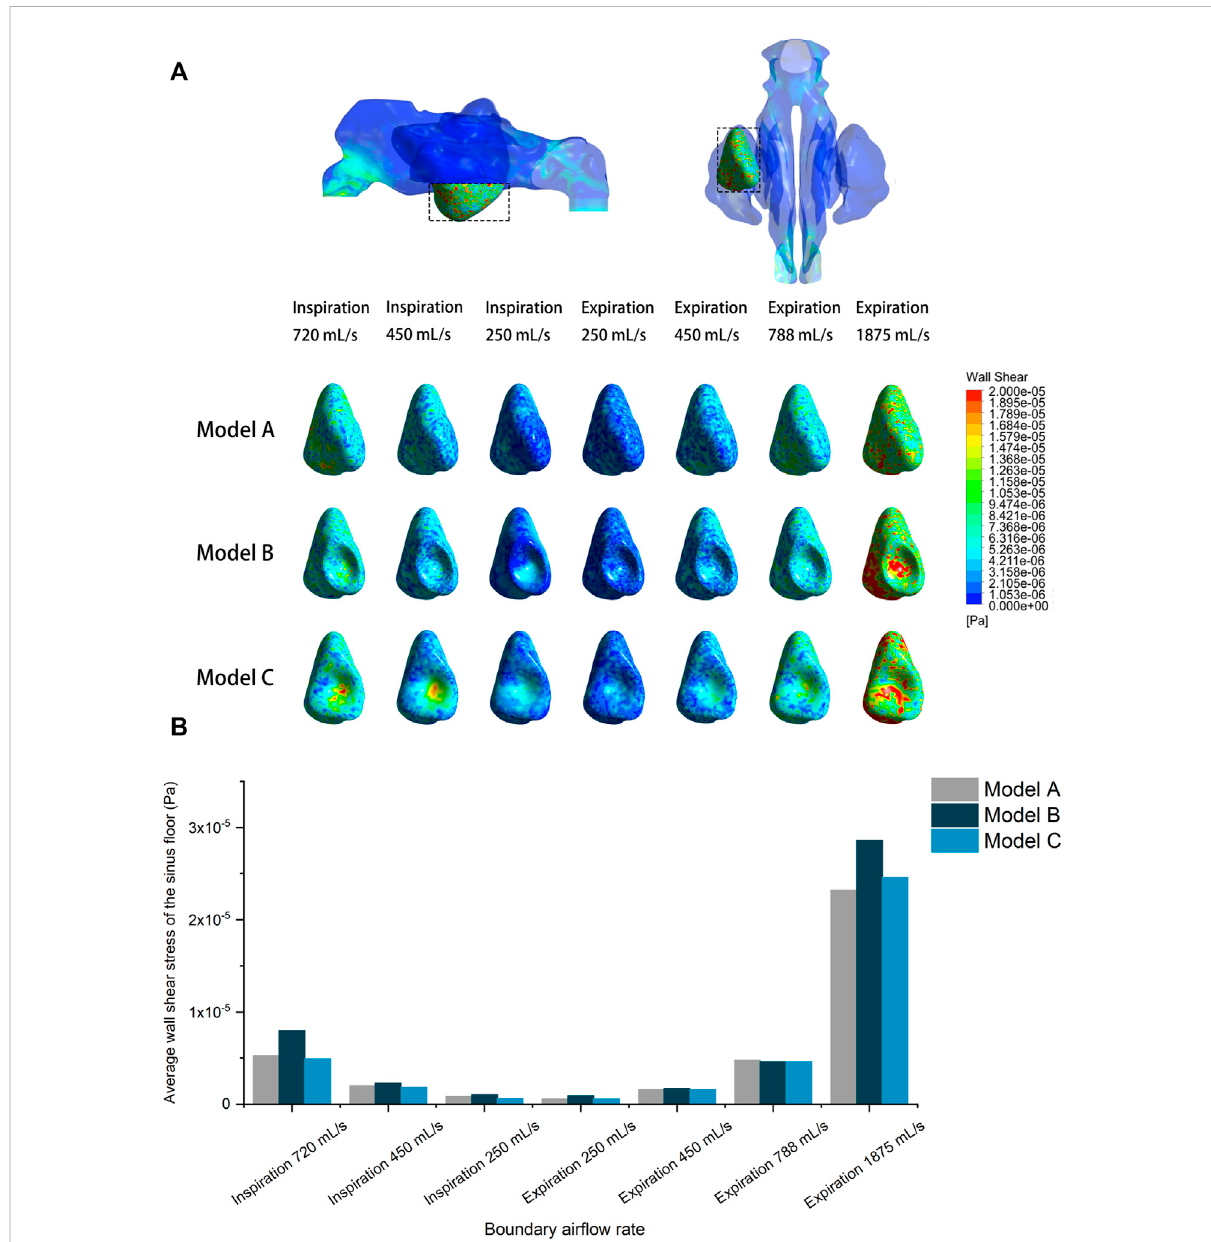
FIGURE 7 (A) Shear stress distribution of the pre- and post-operative sinus fl oor under different inlet fl ow rates. (B) Quantitative comparison of average wall shear stress on the pre- and post-operative sinus fl oor under different fl ow